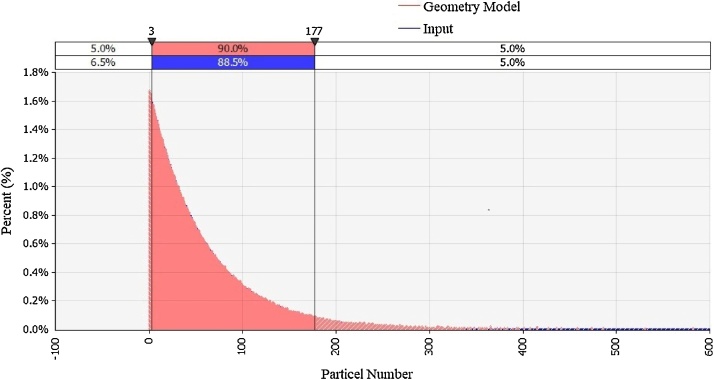
Particle number per cm3.